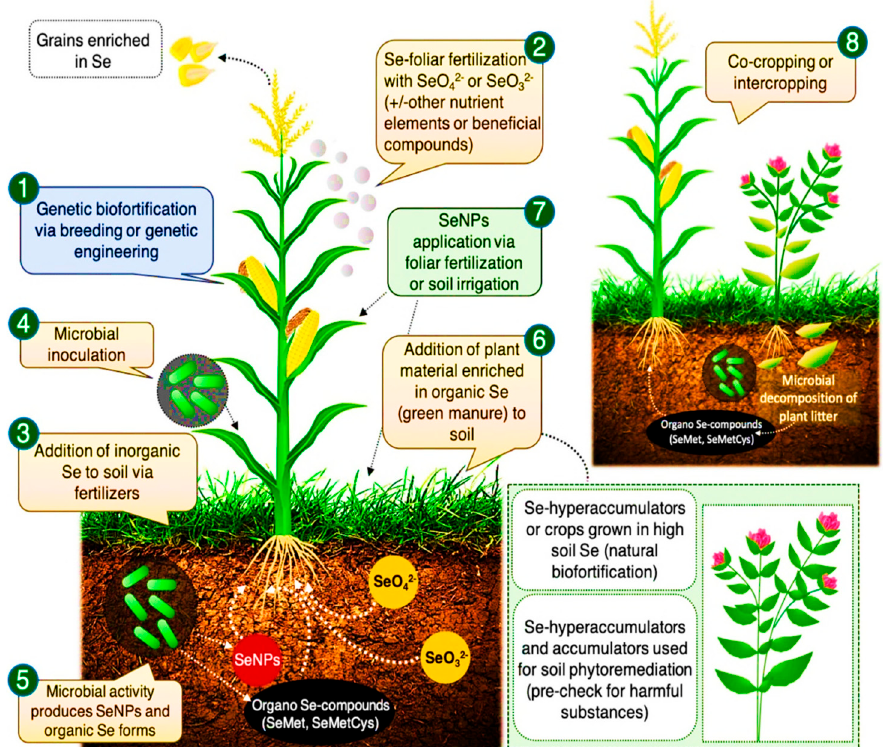
Figure 4. Se biofortification promotes crop yields and quality parameters. Se-biofortification ap- proaches include ( 1 ) genetic tools, ( 2 ) through foliar application, ( 3 ) soil amendment, ( 4 ) agronomic biofortification, ( 5 ) broadcasting into soils, ( 6 ) green manure with Se, enriched growth and development of plants, ( 7 ) nano-sized biofortification to leaves or soil, and ( 8 ) intercropping with Se- hyper-accumulator plants. Adapted and modified from Schiavon et al. [132].